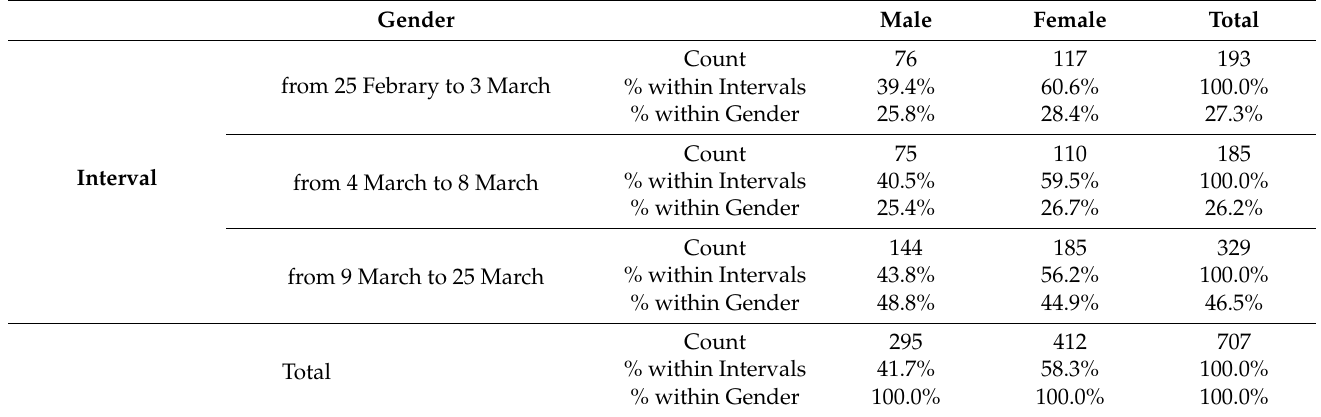
Table 3. Time interval in relation to participants’